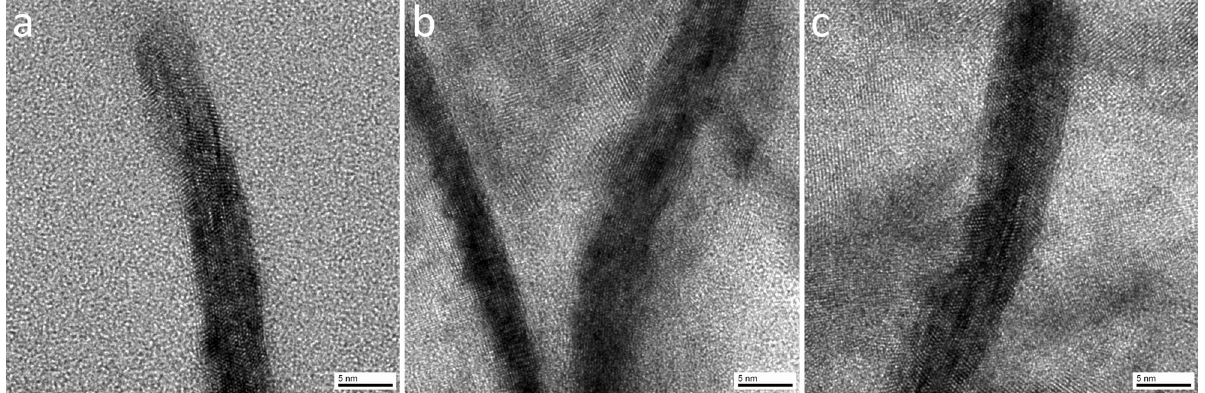
Figure 9. ( a ) Cross-sectional TEM image of the tip of the SnO 2 nanosheet from a direction parallel to the plane. ( b , c ) Cross-sectional TEM image of the middle of the SnO 2 nanosheets from a direction parallel to the